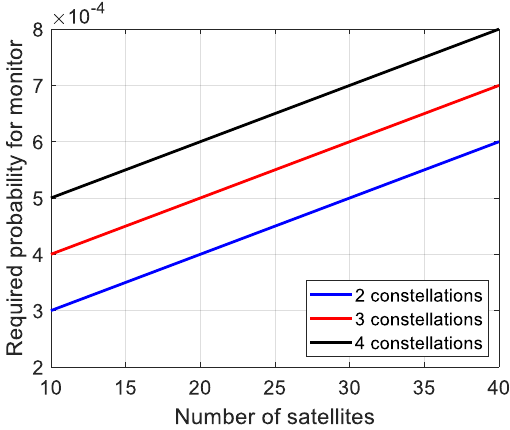
Figure 2. Required probability for monitor.